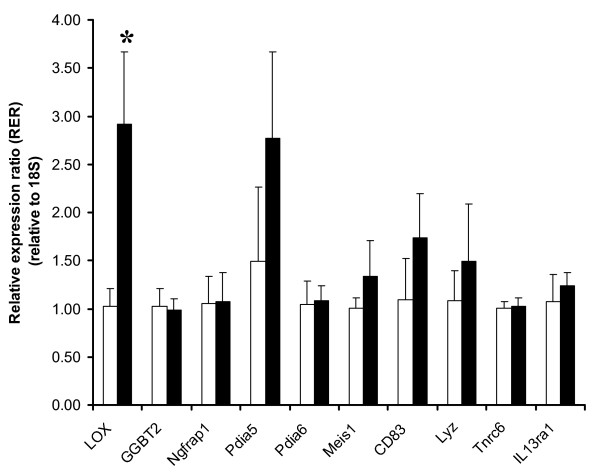
Validation of differentially expressed genes by real-time qPCR. Relative quantification of ten representative genes was performed. The method of Livak and Schmittgen (2001) was used to calculate the relative expression ratio (RER) that were normalized to a housekeeping gene 18S. Normal oocyte developmental competence (NDC) (solid bar) were expressed over poor oocyte developmental competence (PDC) (open bar), positive ratio refers to genes up-regulated, negative ratio indicated gene down-regulation, by which real-time qPCR data in the gene regulation trend (up- vs. down-regulation) were consistent with results obtained from microarray, of which the expression level of Lox (asterisk) was significantly higher in NDC in comparison to PDC (P < 0.05).